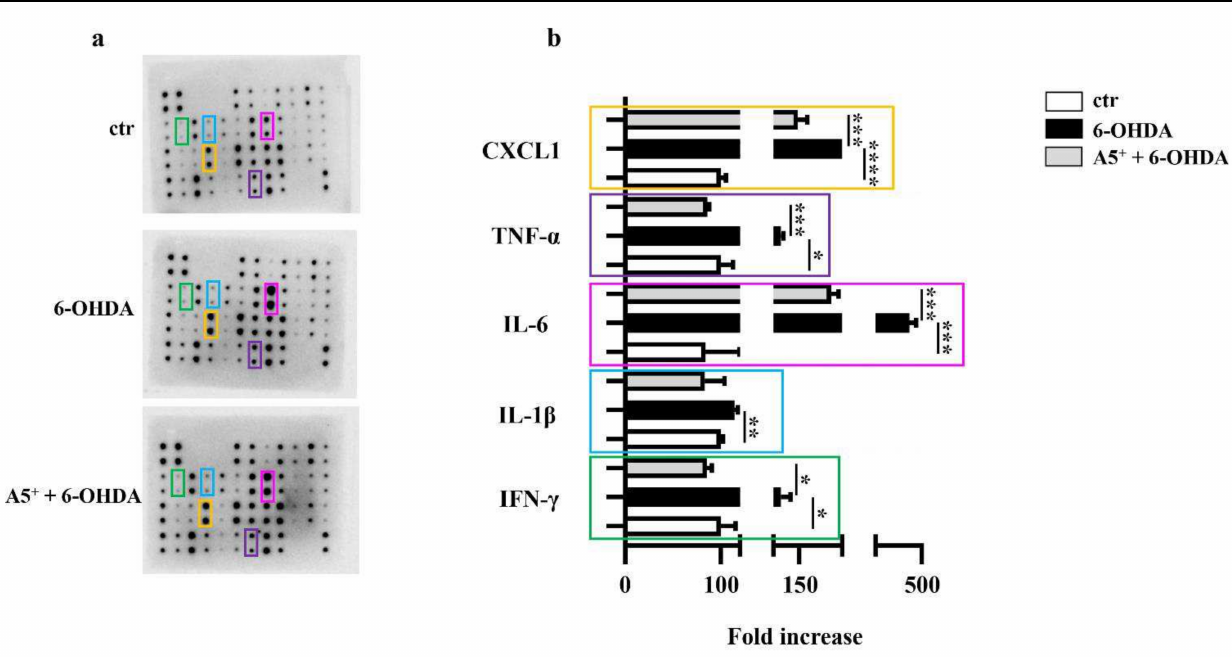
Figure 2. A5 + reduced neuroinflammation induced by 6-OHDA. ( a ) Representative blot assay report- ing all cytokines evaluated; ( b ) Bar graph illustrating the most relevant cytokines modulated by both 6-OHDA and A5 + administration. Data are reported as mean ± SEM ( n = 4). (* p < 0.05; ** p < 0.005; *** p < 0.001; **** p < 0.0001). ctr: control; 6-OHDA: 6-hydroxydopamine; IFN- γ : Interferon- γ ; IL-1 β : Interlukin-1 β ; TNF- α : Tumor Necrosis Factor- α ; CXCL1: chemokine (C-X-C motif) ligand